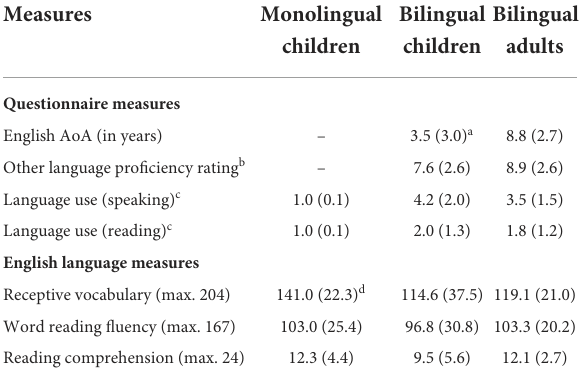
TABLE 1 Means and standard deviations (in parentheses) for background and language measures for each